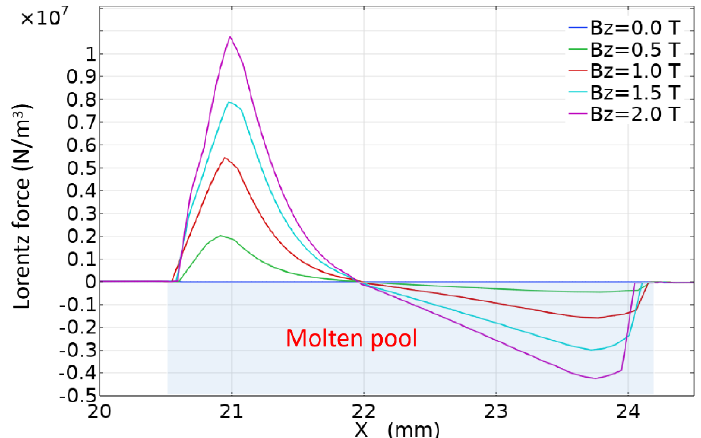
Figure 11. Lorenz force distribution at different magnetic fields (t = 4.5 s).